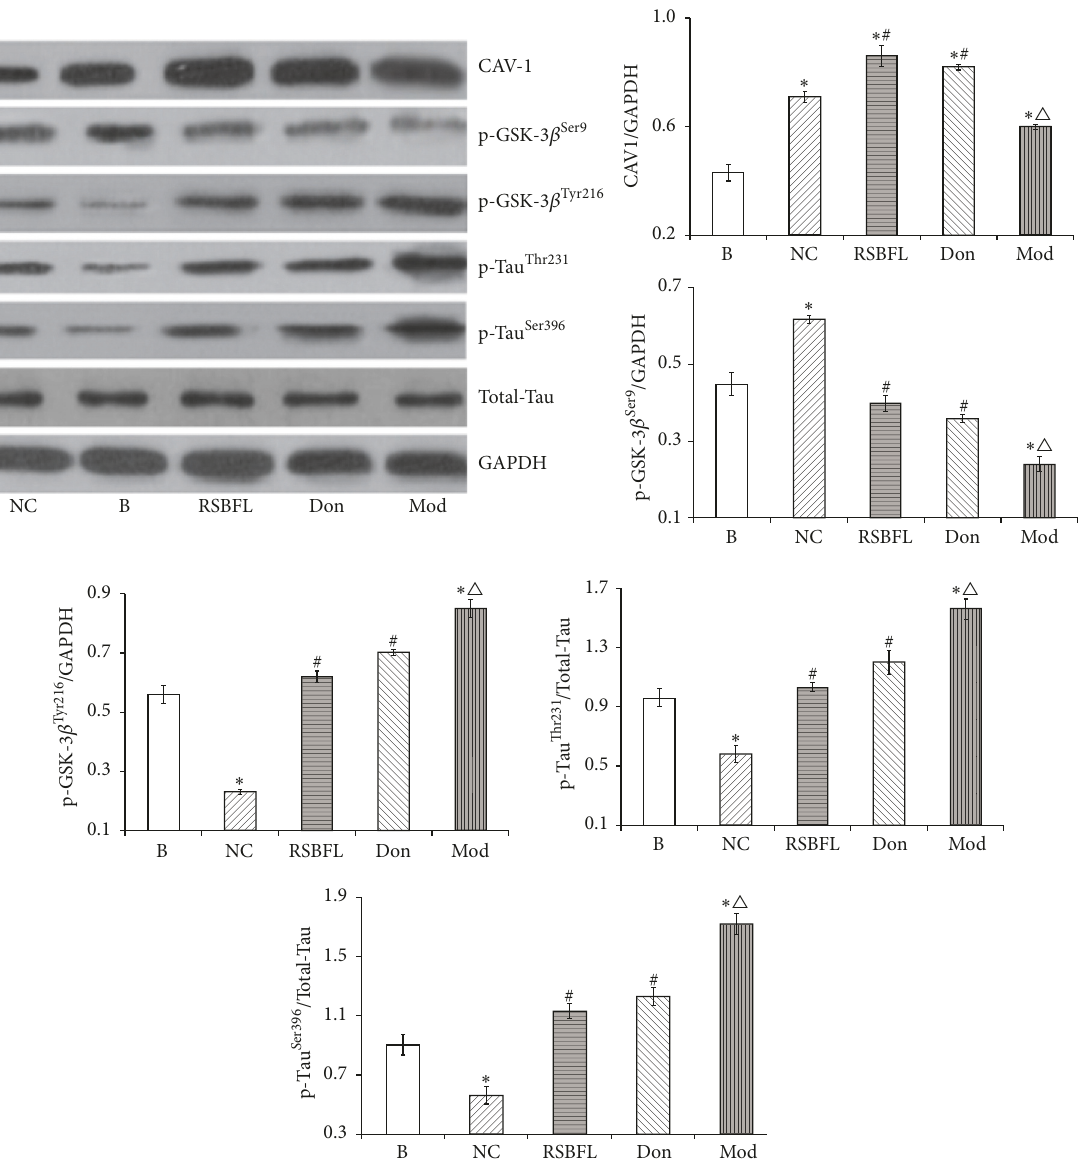
Figure 7: The expression of CAV1, p-Tau, and GSK-3 𝛽 in A 𝛽 1–42-induced hippocampal neuron model with AD after treatments with sera containing RSBFL and donepezil. ∗ 𝑃 < 0.05 relative to B group; # 𝑃 < 0.05 relative to Mod group; △ 𝑃 < 0.05 relative to NC group.